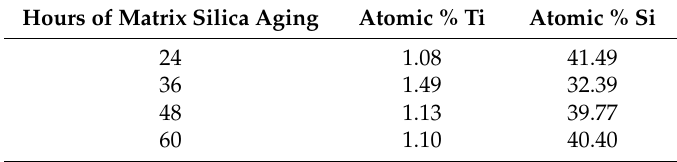
Table 1. Atomic percentages of Ti and Si, determined by energy dispersive X-ray spectroscopy (EDS) analysis, in TiO 2 /SiO 2 -borosilicate glass tubes (BGT), obtained after different time of the matrix silica